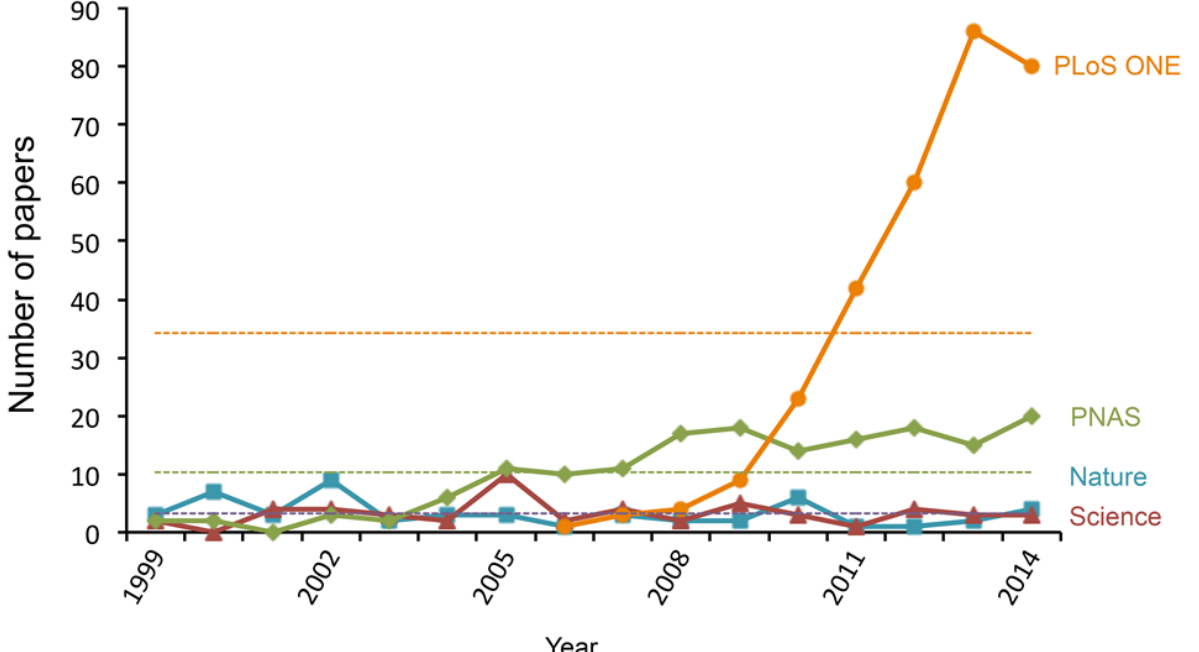
Figure 7. Number of biogeography papers published in four of the most recognized “multidisciplinary sciences” publi- cations, as categorized by Thomson Reuters, annually since 1999, per the Web of Knowledge database (solid lines). Horizontal dashed lines show the long-term mean number of articles per year per journal for the 15 year period ana- lyzed. Articles were identified by the topic word search “biogeography” in the Science Citations Index–Expanded, 13 September